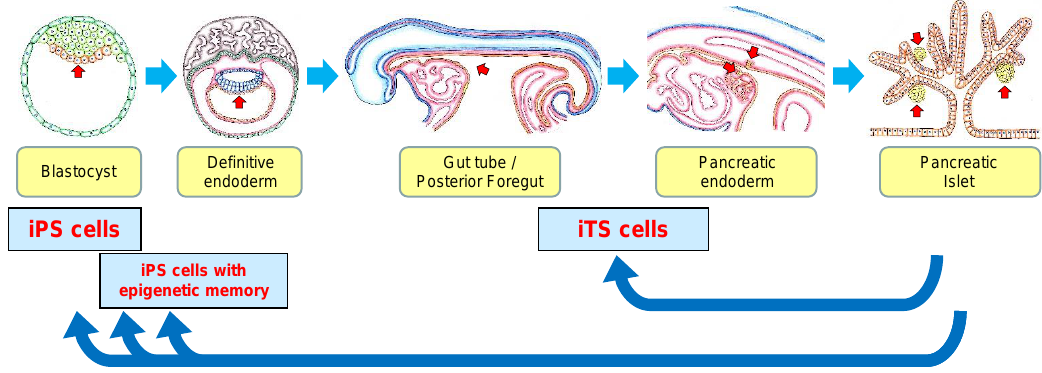
Figure 1. Differentiation of pancreatic islets and generation of iPS/iTS cells. iPS cells have been generated by reprogramming the factors such as Oct4, Sox2, Klf4, and c-Myc. While iPS cells have been shown to be similar to ES cells, several articles have suggested that, following the reprogramming of iPS cells, epigenetic memory is inherited from the parental cells. iTS cells have been generated by the reprogramming factors combined with tissue-specific selection. iTS cells are “incompletely reprogrammed” cells that inherit numerous components of epigenetic memory from donor tissue. Red allows show endodermal cells and pancreatic